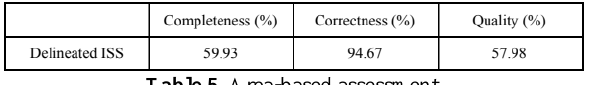
Table 5. Area-based assessment.